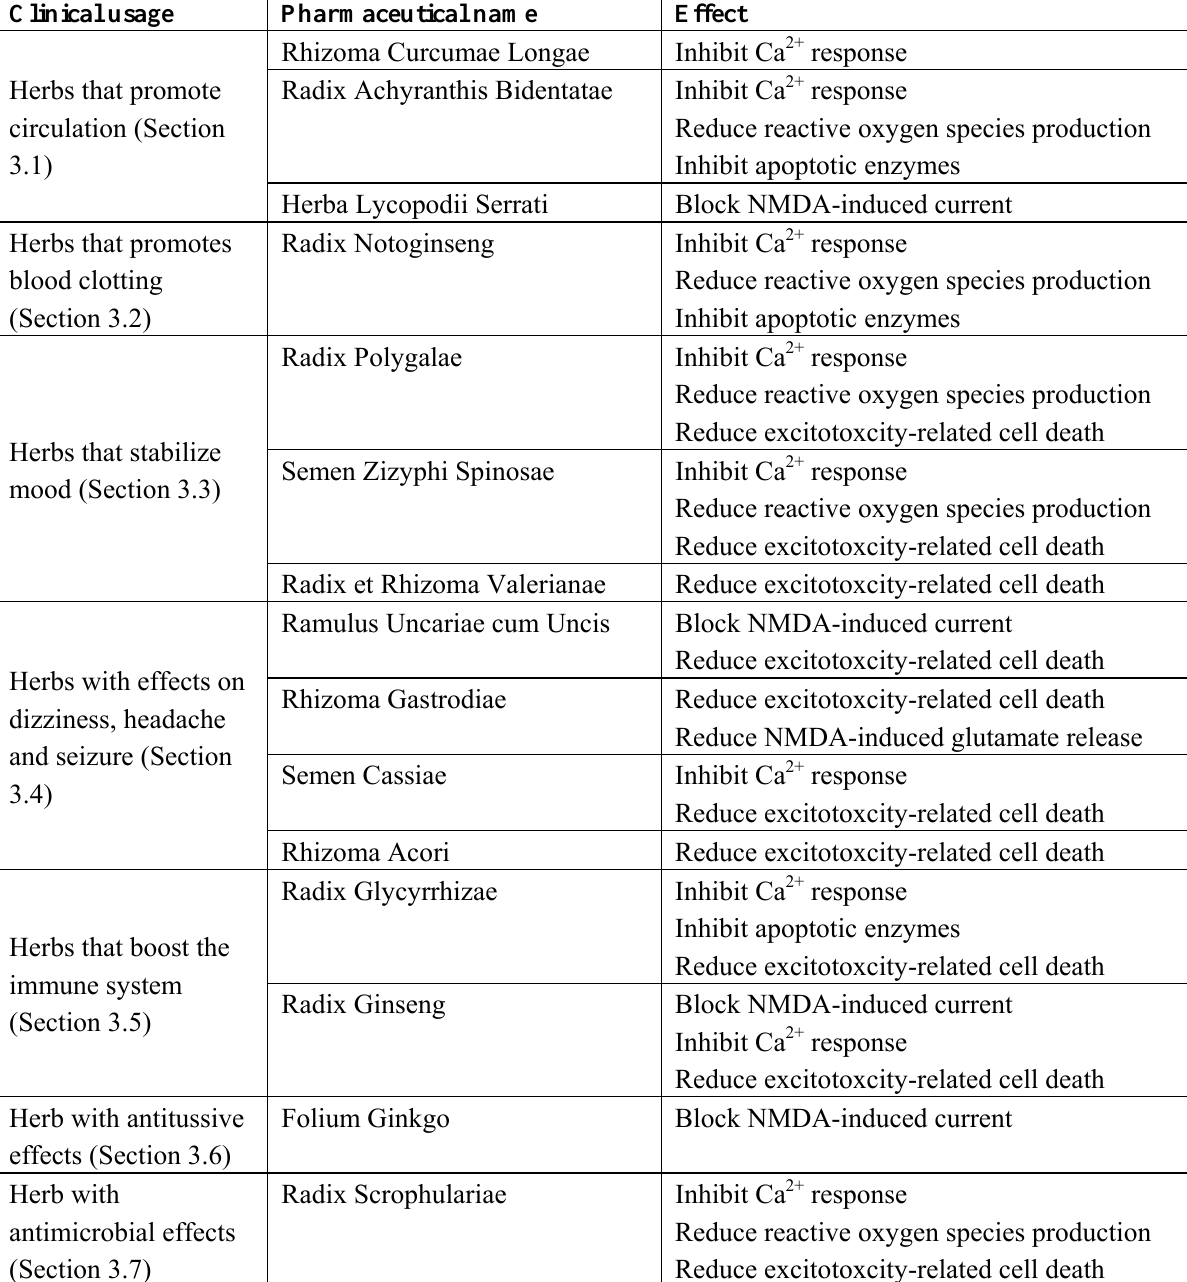
Table 1. A summary of the herbs and their effects on and related to the